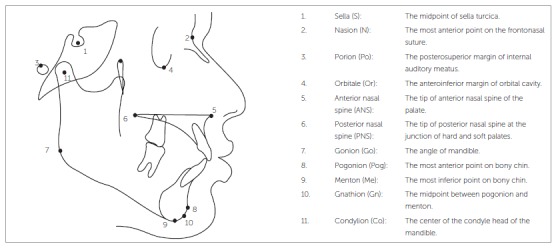
Skeletal landmarks.